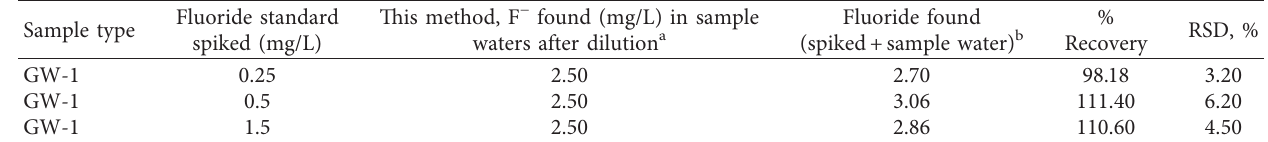
Table 2: Analytical results of groundwater sample analysis via spiking ( n � 3).